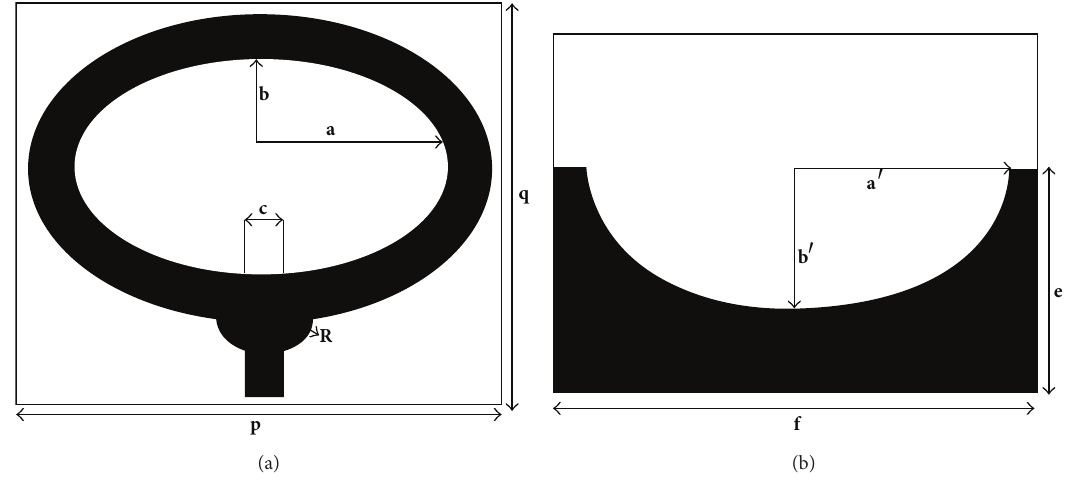
Figure 1: Proposed antenna dimensions (a) patch and (b) ground